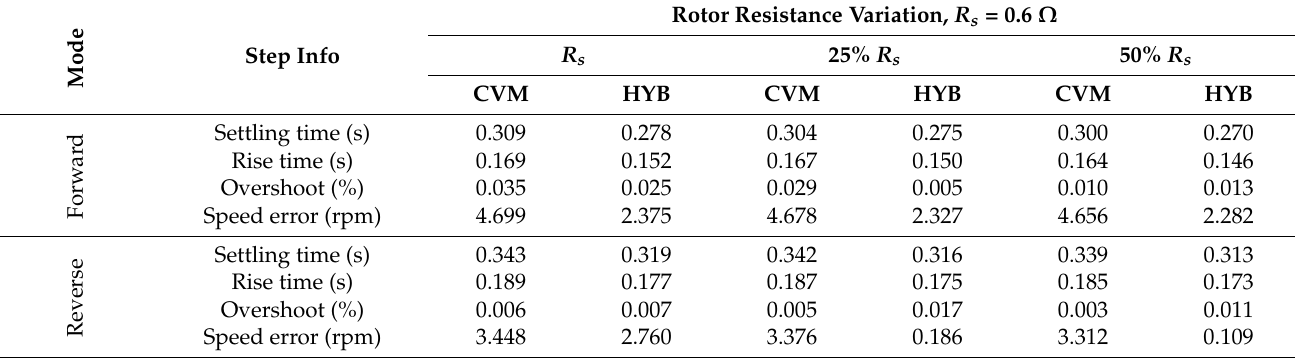
Figure 13. Rotor speed response against stator resistance variation: ( a ) in forward operation and ( b ) in reverse operation. Table 3. Rotor speed performance under stator resistance variation.